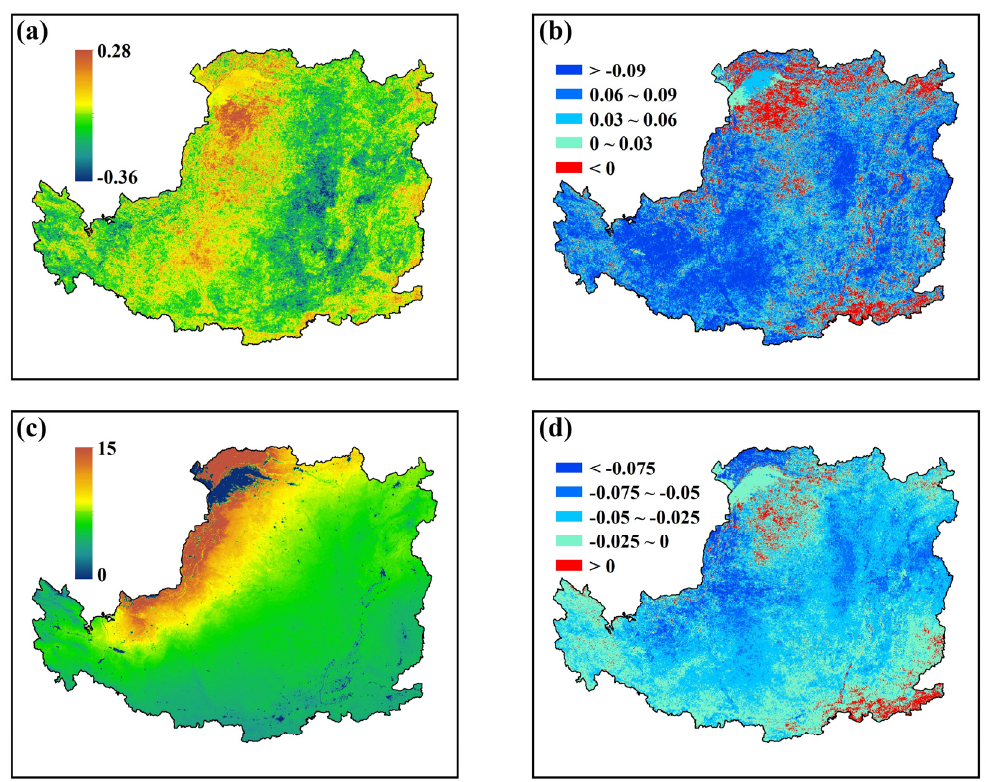
Figure 8. Spatiotemporal change in the SPEI and AI on the LP during 2000–2015: ( a , c ) show the spatial distribution of the annual mean SPEI and AI, respectively; ( b , d ) show the slope of the trends for the SPEI and AI, respectively.